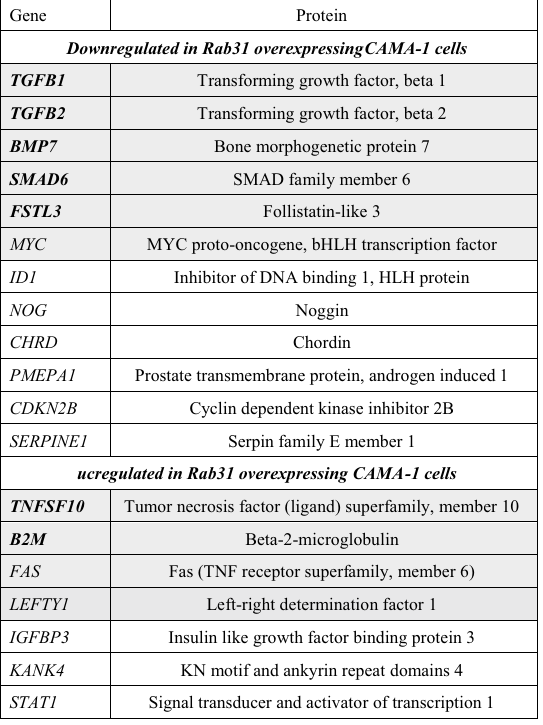
Table 2 Differentially expressed TGF-ß pathway-related candidate genes in Rab31 overexpressing and vector control cells identified by profiler PCR array